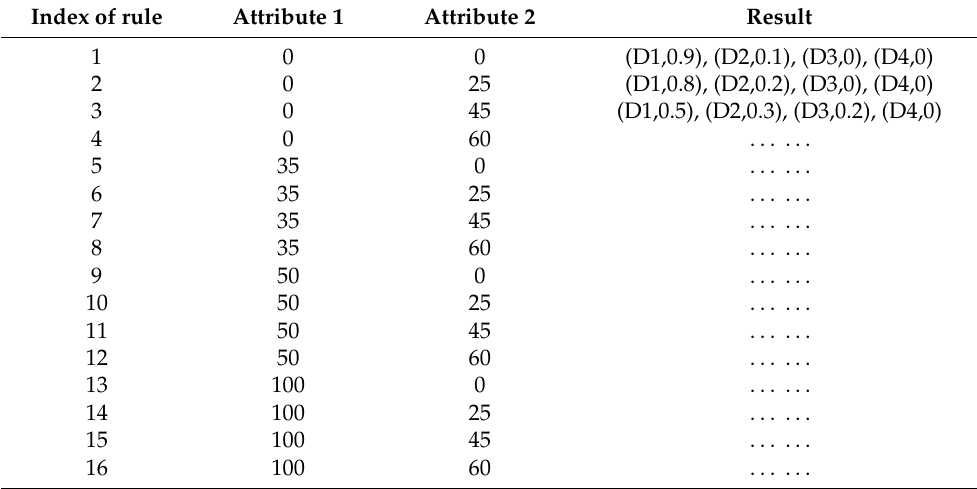
Table 4. Corresponding belief